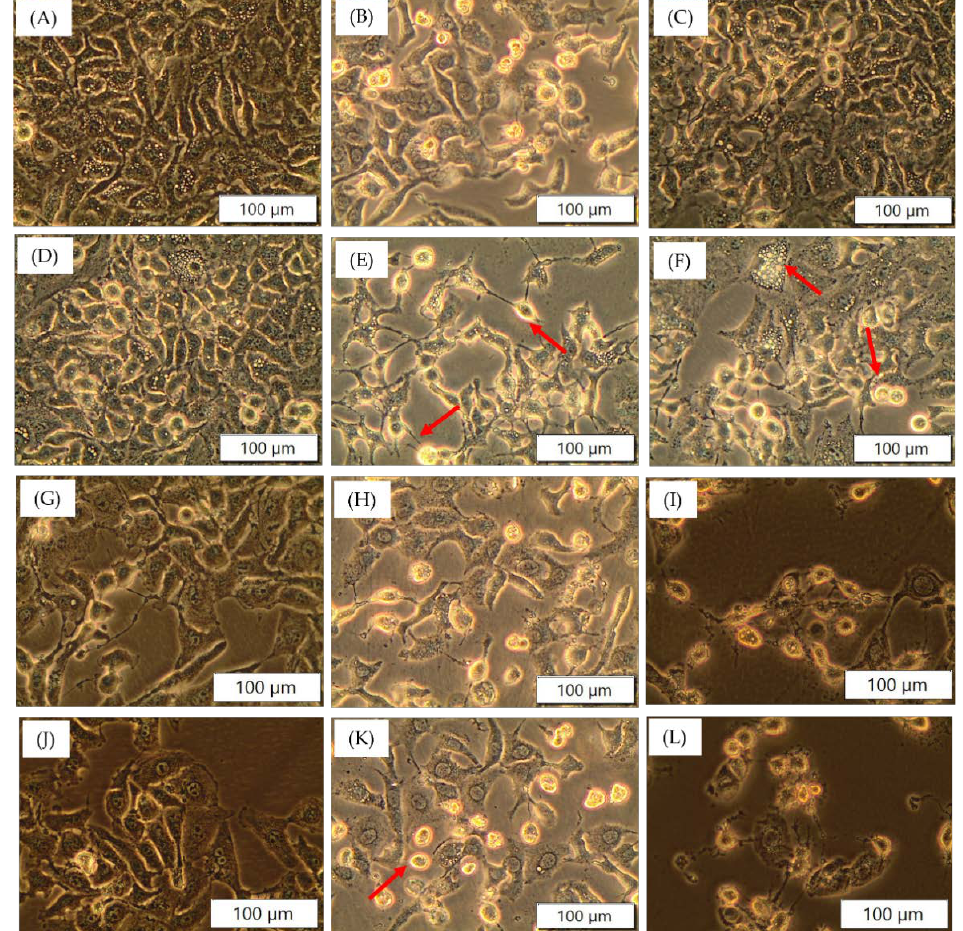
Figure 5. Morphology of A549 treated with cobalt complexes, urea and doxorubicin. ( A ) Control (untreated); ( B ) Dox (50 nM); ( C ) 32 μM ( I ); ( D ) 32 μM ( II ) ( E ) 32 μM ( III ); ( F ) 32 μM ( IV ); ( G ) 32 μM ( III ) +2 mM urea; ( H ) 32 μM ( III ) + 50 nM Dox; ( I ) 32 μM ( III ) + 2 mM urea + 50 nM Dox; ( J ) 32 μM ( IV ) +2 mM urea; ( K ) 32 μM ( IV ) + 50 nM Dox; ( L ) 32 μM ( IV ) + 2 mM urea + 50 nM Dox. Intact